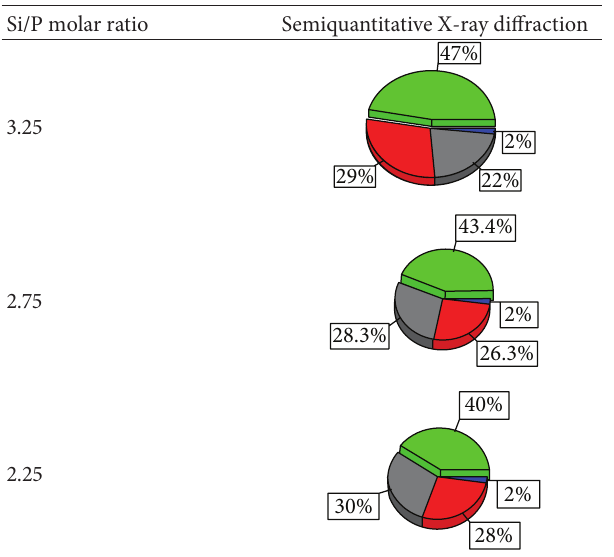
Table 4: The semiquantitative X-ray diffraction of the crystalline phases in the obtained geopolymers.